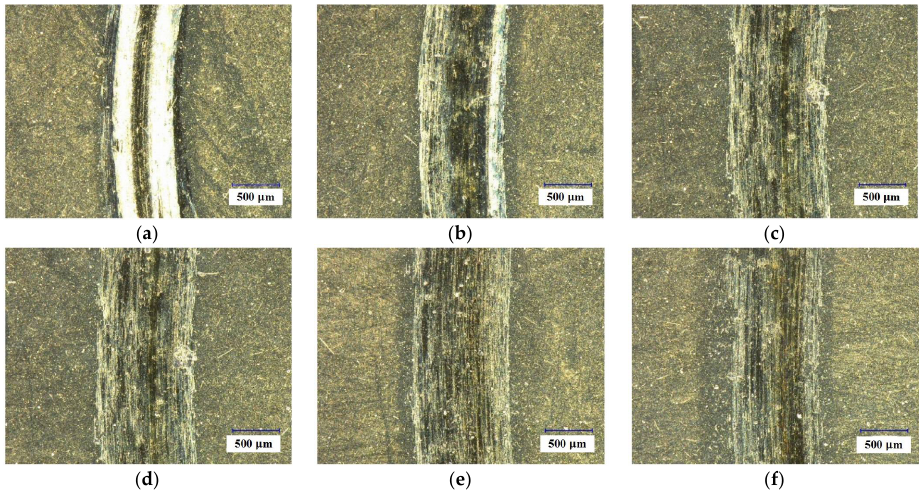
Figure 6. Micrographs of the wear surfaces of ZGC under different speeds. ( a ) 40 m/min; ( b ) 60 m/min; ( c ) 80 m/min; ( d ) 100 m/min; ( e ) 120 m/min; ( f ) 140 m/min. (Load 15 N, sliding time 5 min).